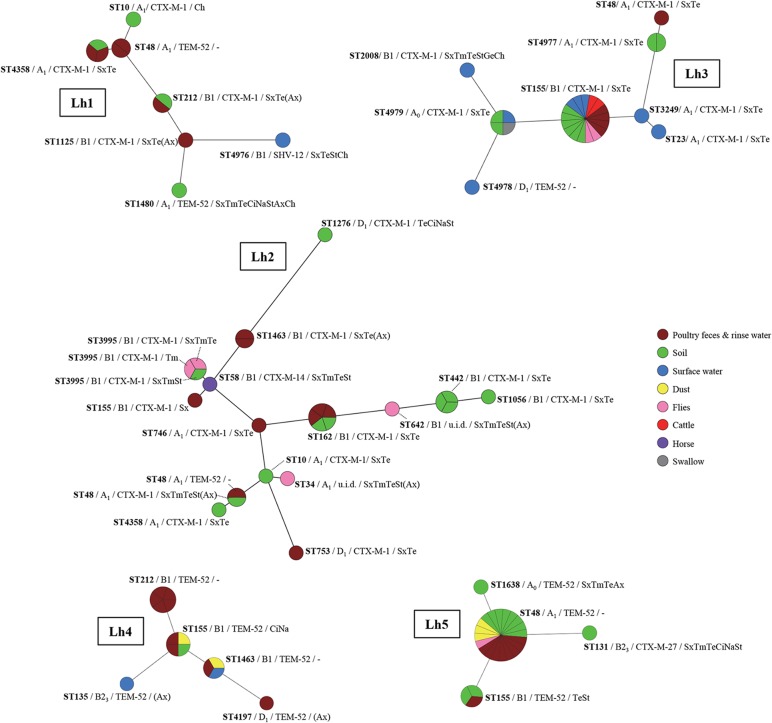
ESBL-producing E. coli variants on laying hen farms.Maximum parsimony trees constructed based on the concatenated sequences of the seven MLST alleles, using Bionumerics 7.1 software. Node sizes reflect the number of isolates per ST and node colours represent different matrices. Additionally indicated are the phylogenetic group, ESBL-genotype and ABR profiles of isolates in every node (i.e., ST). Note that per sample maximally one isolate of each variant was included, and that multiple isolates of a specific variant reflects detection in multiple samples. ABR profiles represent antibiotics to which resistance was observed additionally to 3rd generation cephalosporins. In between brackets are antibiotics with MICs just above and just below epidemiological cut-off values (i.e. with a maximal 2-fold difference) among isolates with the same ST and/or ESBL genotype. Sx = sulfamethoxazole, Tm = trimethoprim; Te = tetracycline, Ci = ciprofloxacin, Na = nalidixic acid, St = streptomycin, Ge = gentamycin, Ax = amoxicillin+clavulanic acid, Ch = chloramphenicol; u.i.d. = unidentified.